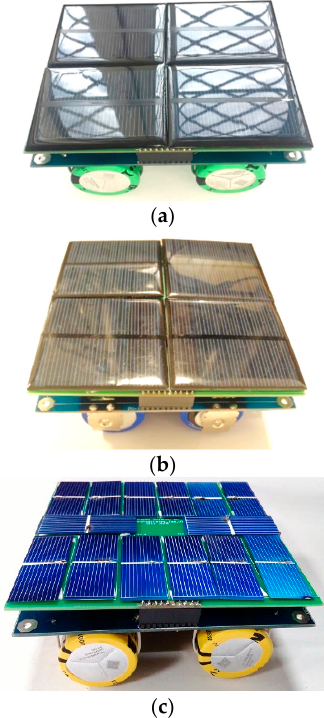
Figure 3. Images of three types of created demonstrators of energy storage systems based on: ( a ) demonstrator no. 1, ( b ) demonstrator no. 2, and ( c ) demonstrator no. 3. Visualization of a printed electric board with photovoltaic elements in parallel–series connection, and series connection of 14 PV elements is presented in Figure 4.